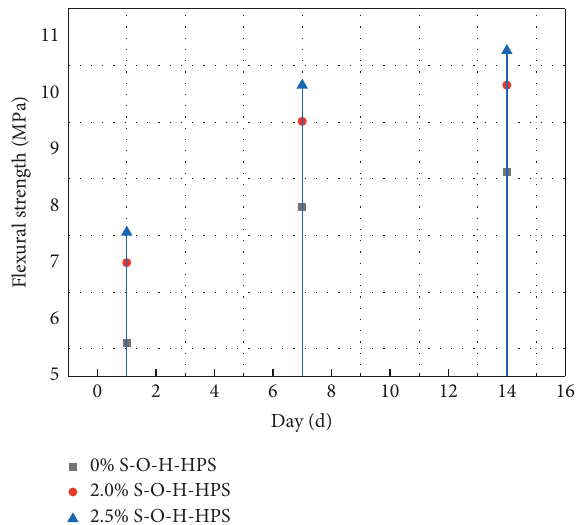
Figure 11: Effect of curing age on shear strength of cement stone.